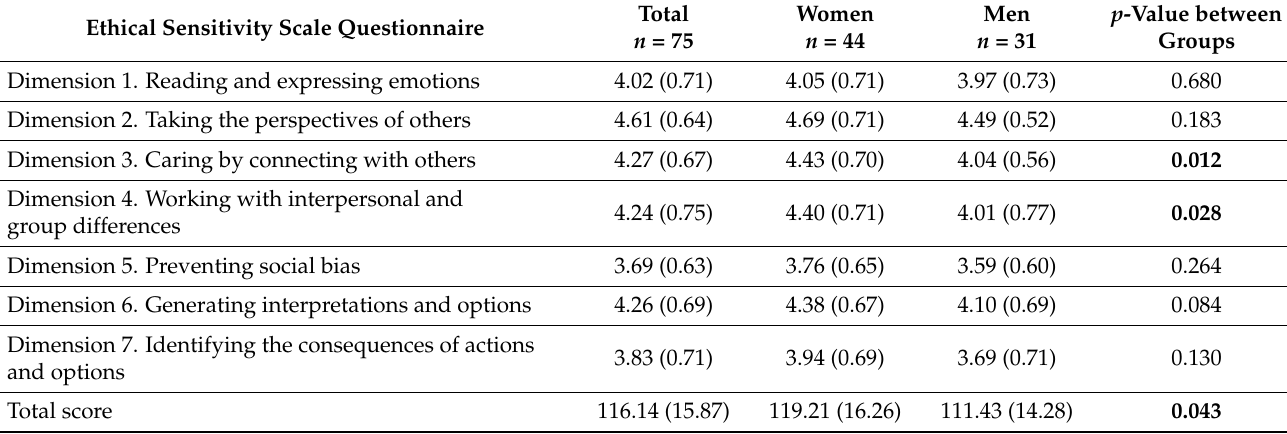
Table 2. Results of the Ethical Sensitivity Scale